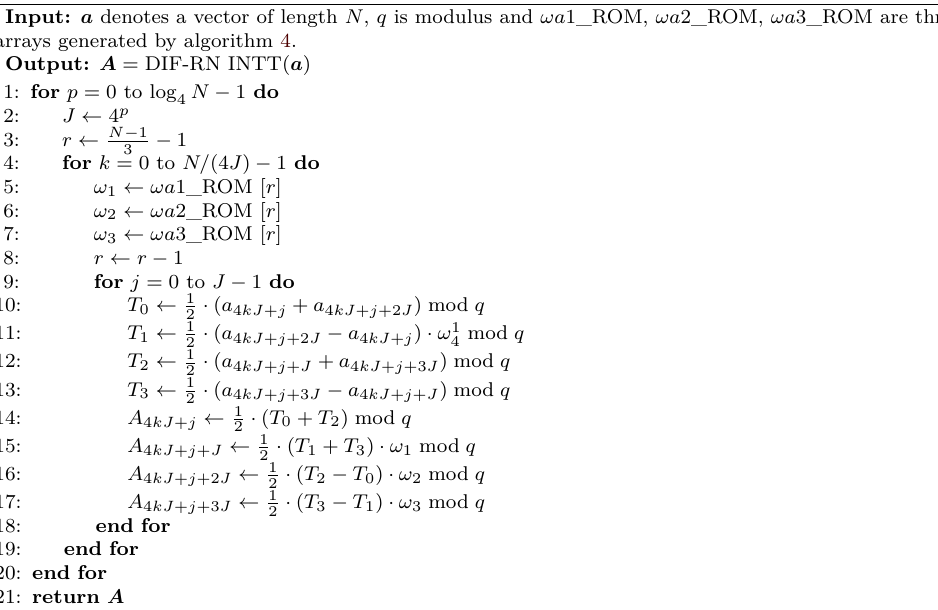
Algorithm 5 Radix-4 DIF-RN INTT